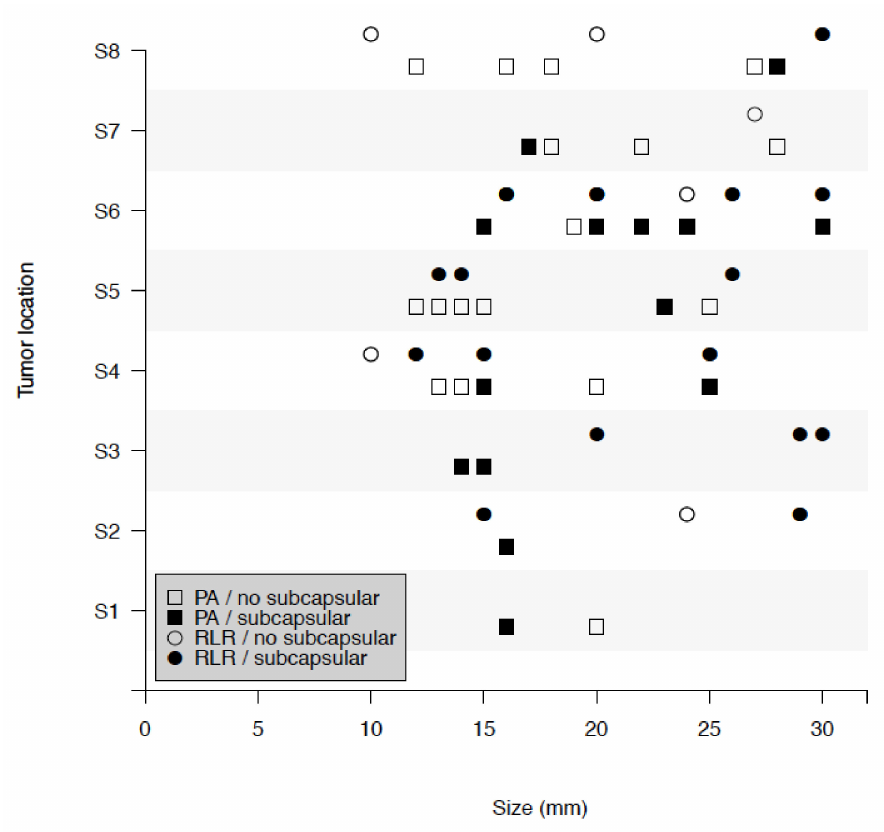
Figure 1. Tumor location and tumor size, among patients with percutaneous ablation (PA) and robotic liver resection (RLR) with and without subcapsular hepatocellular carcinoma